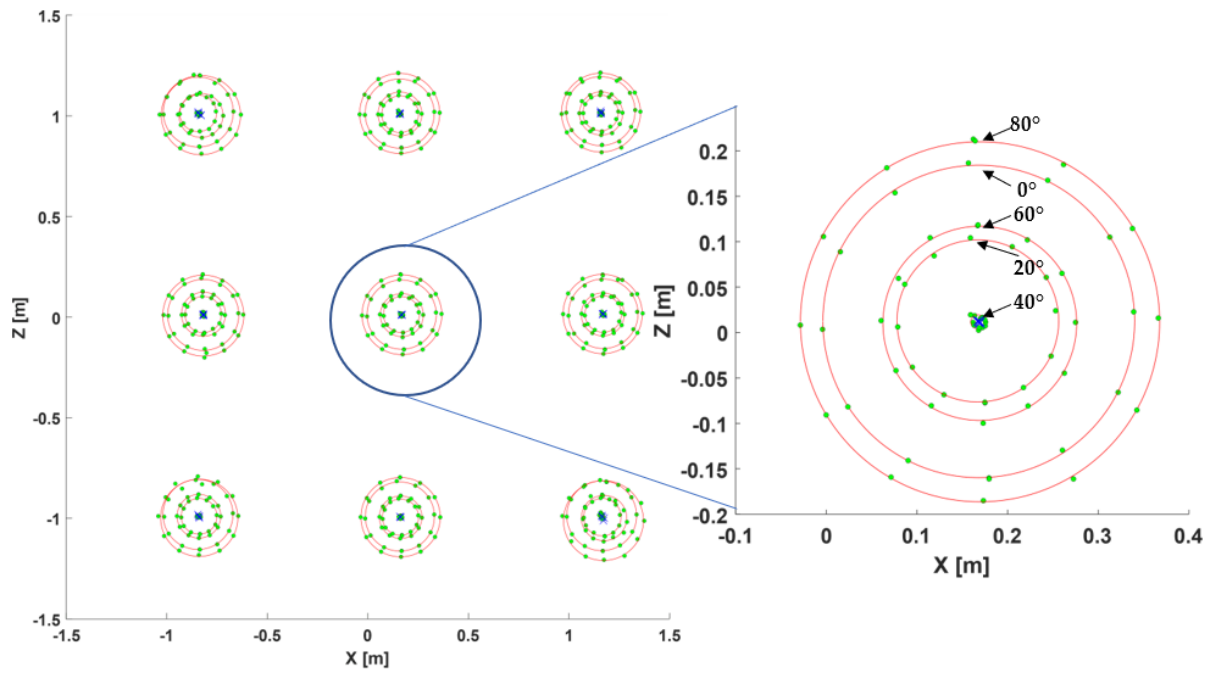
Figure 5. Tracker positions during measurements (top view). The dots indicate the tracker’s position, the red lines represent the circles with a radius determined from the results, and the crosses indicate their centres.